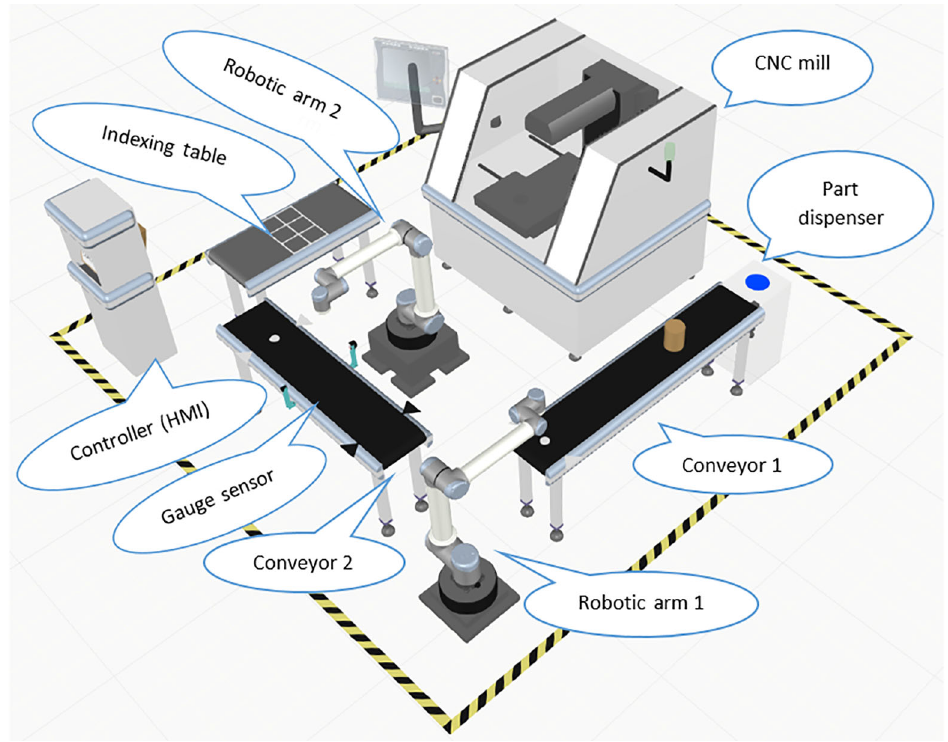
Fig. 4. Manufacturing system components and